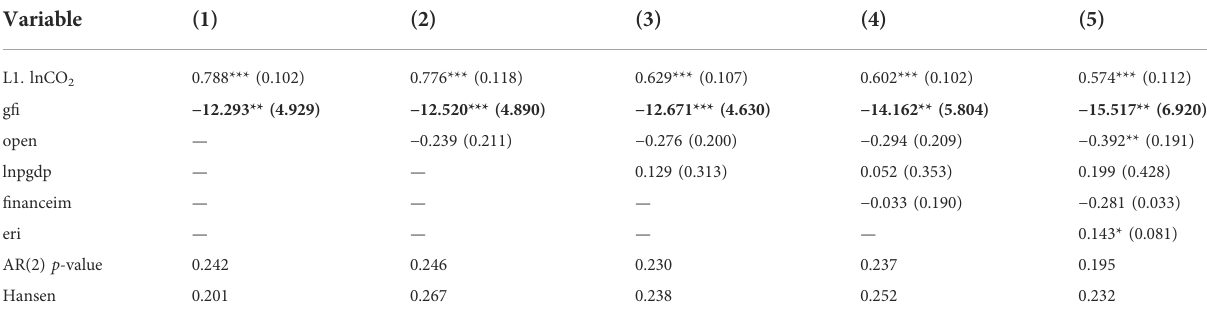
TABLE 8 Results of stepwise regression of GMM model.